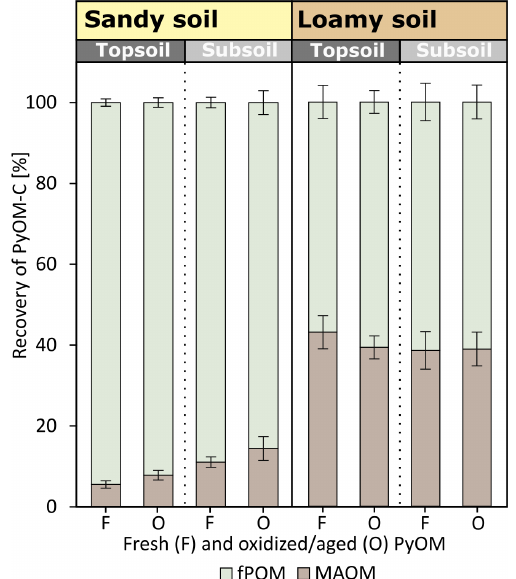
Figure 6. Relative recovery of fresh (F) and oxidized (O) PyOM-C in fPOM and MAOM fractions in the first layer below the soil– PyOM layer (0–2.3cm) of sandy and loamy topsoil and subsoil ( ± 1SE).